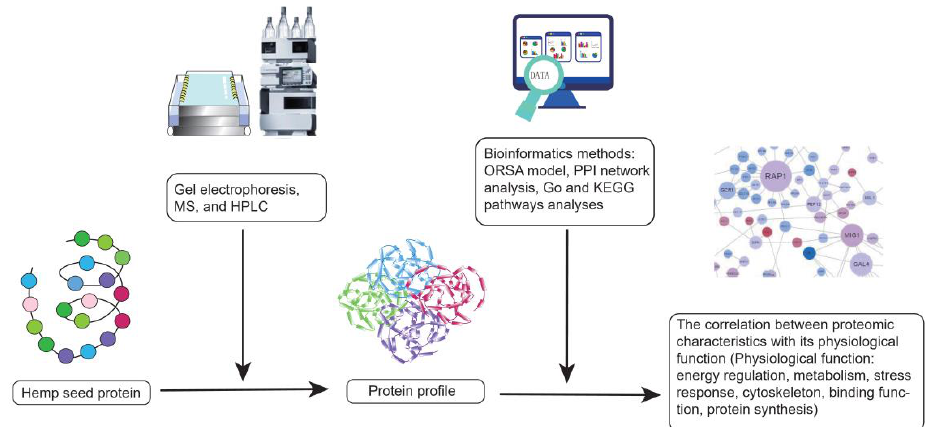
Figure 5. The experimental flow chart of protein